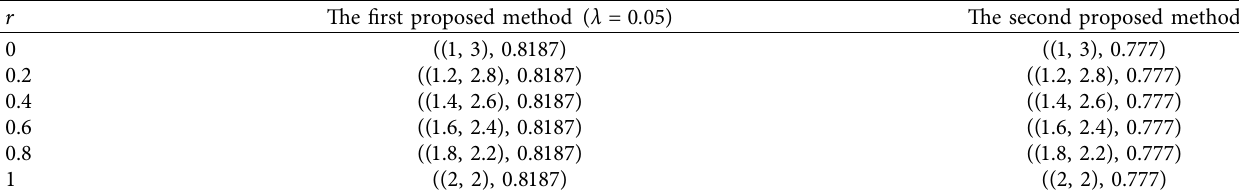
Table 5: Comparison of 􏽥 u